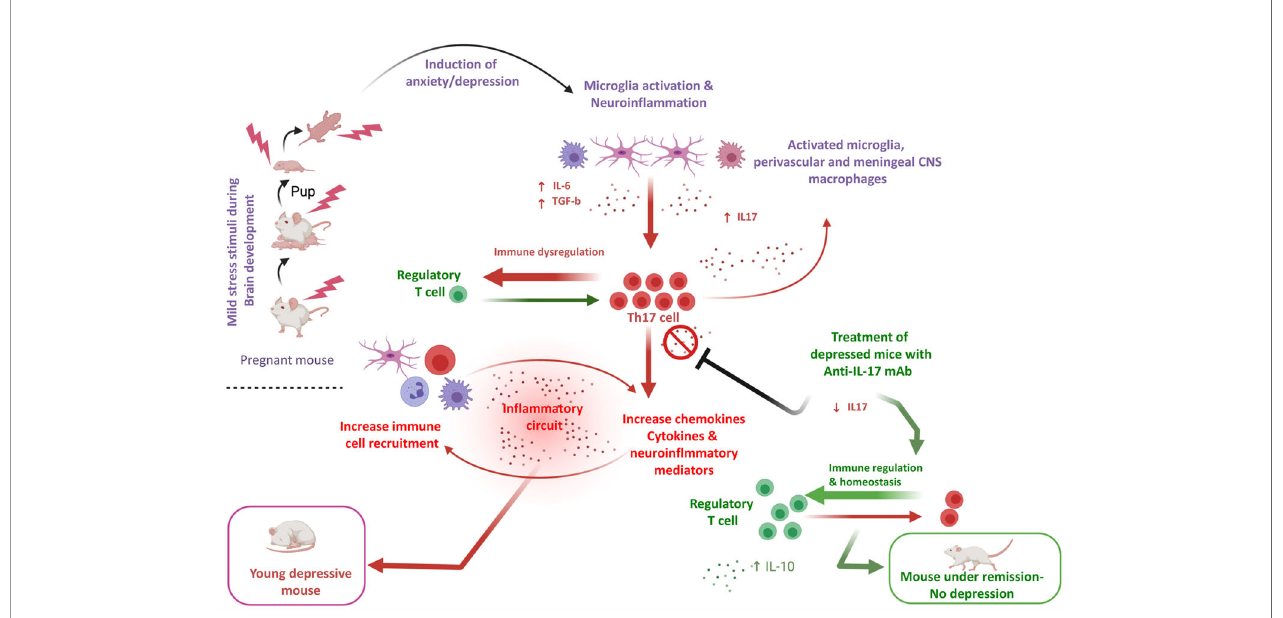
FIGURE 1 | An-IL-17-mediated hypothesis of depressive disorder in an experimental model. In a young adult depression mouse model exposed to cumulative mild stress (CPMS) characterized by microglial activation, IL-17 in brain and blood, as well Th-17 cells are elevated. A hypothesis based on the assumption that microglia activation is pivotal for the increase of pro-in fl ammatory cytokines such as IL-16 and TGF-b, which polarize CD4+ T cells towards Th-17 is formulated. Experimental data suggest that anti-IL-17 mAb treatment, diminishes IL-17 induction and Th-17 differentiation and ameliorates anxiety and depression-like behaviors (61) (prepared with